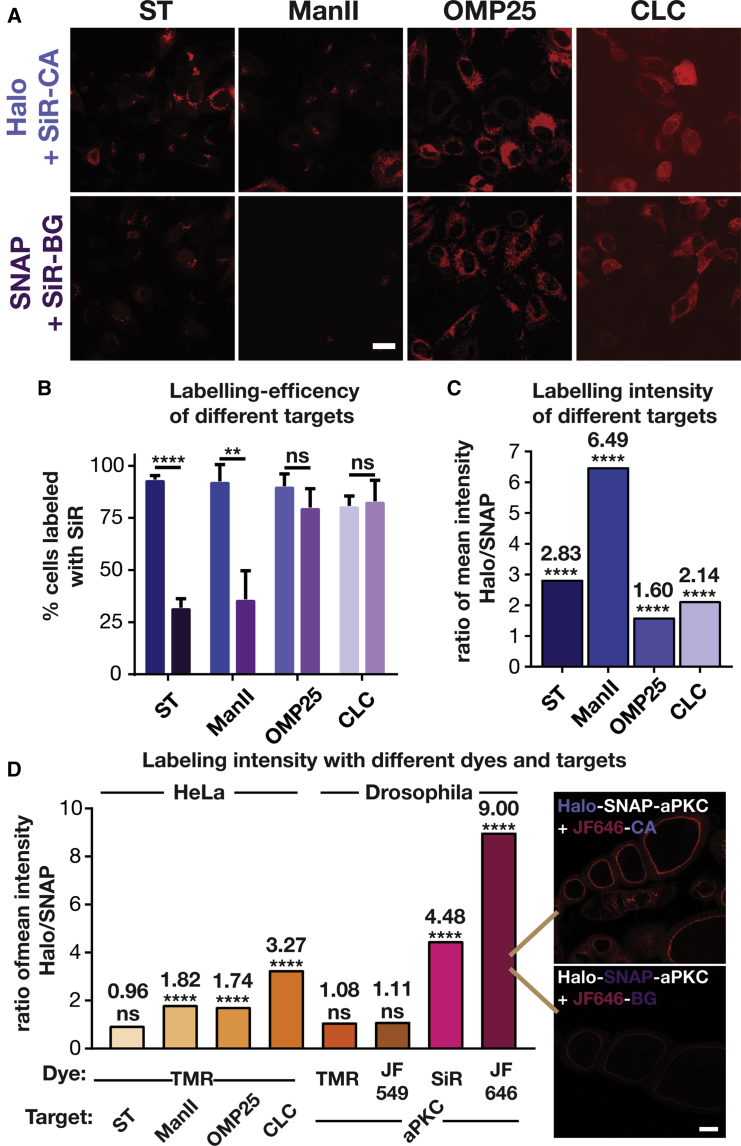
Comparison of HaloTag and SNAP-Tag Labeling with Various Fluorophores of Various Targets in HeLa Cells and Drosophila(A) Confocal images of HeLa cells expressing Halo and SNAP fusion proteins of sialyltransferase (ST), mannosidase II (ManII), outer membrane protein 25 (OMP25), and clathrin light chain (CLC) that have been labeled with the corresponding SiR substrates. Scale bar: 20 μm.(B) Labeling efficiency of different targets. The bar graph shows the number of ManII-GFP-expressing cells that were positive for labeling of a fusion protein with SiR from three independent experiments (total number of cells for ST: Halo, 740, SNAP, 837; ManII: Halo, 344, SNAP, 436; OMP25: Halo, 563, SNAP, 524; CLC: Halo, 630, SNAP, 460). Left bars, Halo; Right bars, SNAP.(C) Comparison of the ratio of the mean intensity of various SiR-labeled Halo and SNAP fusion proteins. The intensity distribution for each protein and number of cells analyzed are shown in Figure S4.(D) Comparison of the ratio of the mean intensity of Halo and SNAP fusion proteins labeled with TMR, JF549, SiR, and JF646 in HeLa cells and Drosophila egg chambers. The intensity distribution for each protein and number of cells analyzed are shown in Figures S6 and S7. Inset shows the dramatic difference in staining between JF646-CA and JF646-BG in egg chambers. Scale bar: 20 μm.